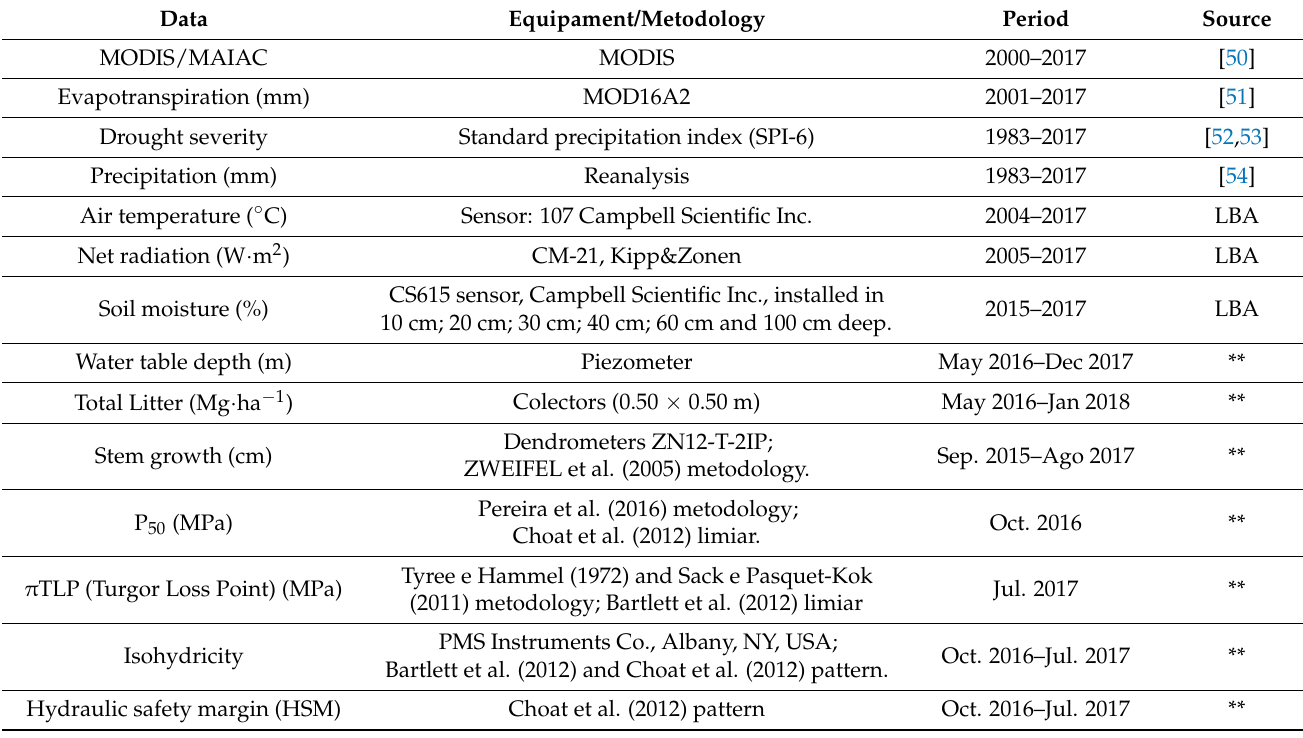
Table 1. Summary of the data used in this